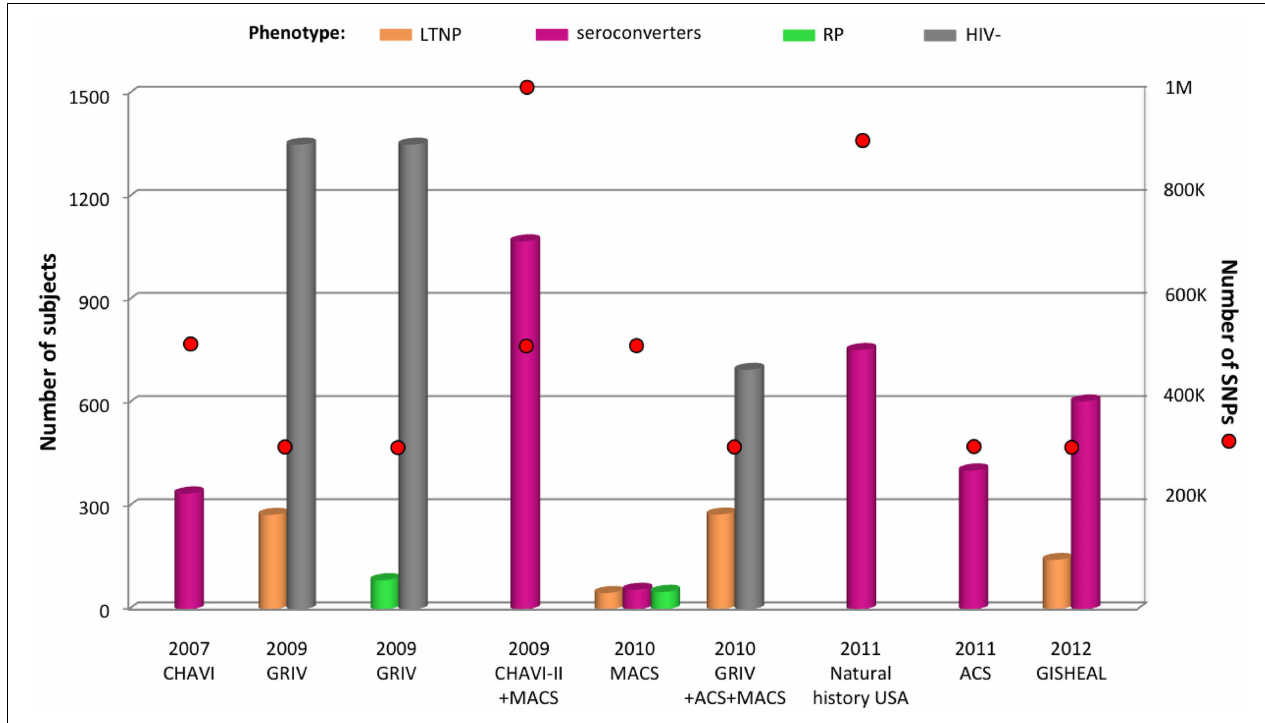
ancestry.The different phenotypes are color-coded: gold for long-term non-progressors (LTNP), pink for medium seroconverters, green for rapid progressors (RP), and gray for uninfected individuals.The natural history USA study comprises seroconverters from the following cohorts: ALIVE, DCG, HGDS, MACS, MHCS, and